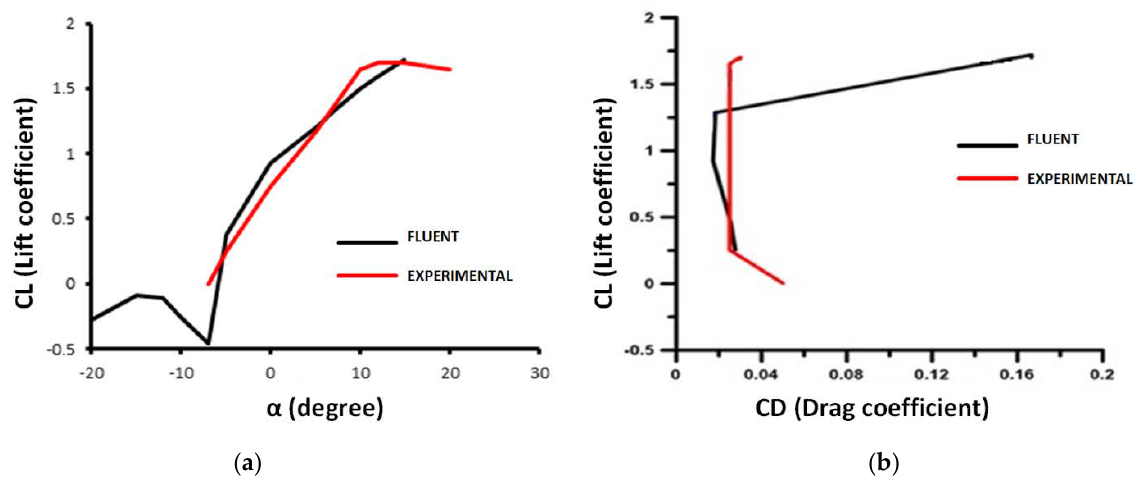
Figure 5. The validation results for FX63-137 of FLUENT and the experimental work presented in [34] ( a ) lift coefficient vs. the angle of attack α° ( b ) lift coefficient, wherein C l vs. the drag coefficient C d